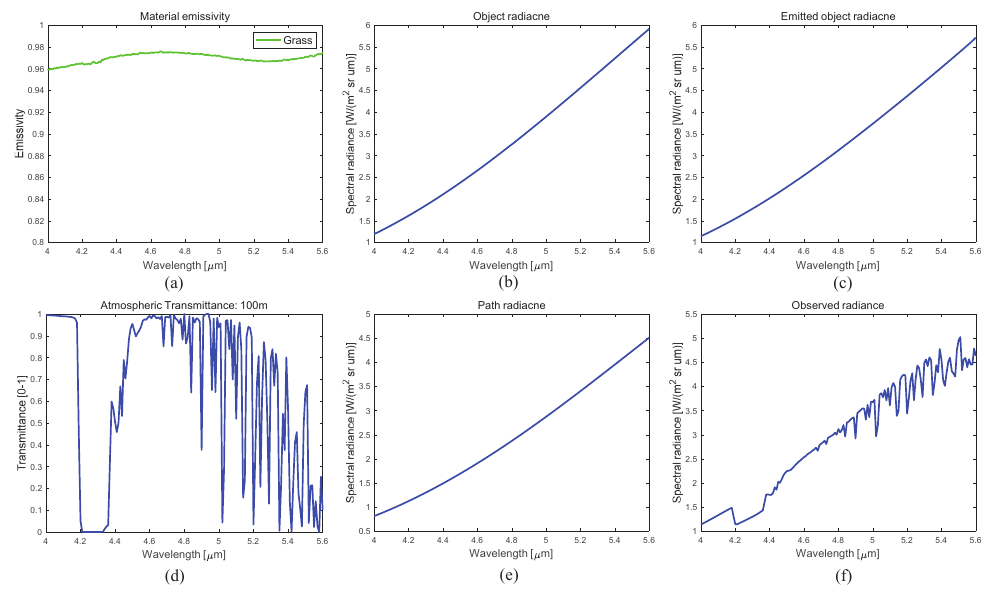
Figure 14. Synthetic spectrum generation flow: ( a ) grass emissivity, ( b ) object radiance, ( c ) emitted object radiance, ( d ) atmospheric transmittance, ( e ) path radiance, and ( f ) observed radiance.